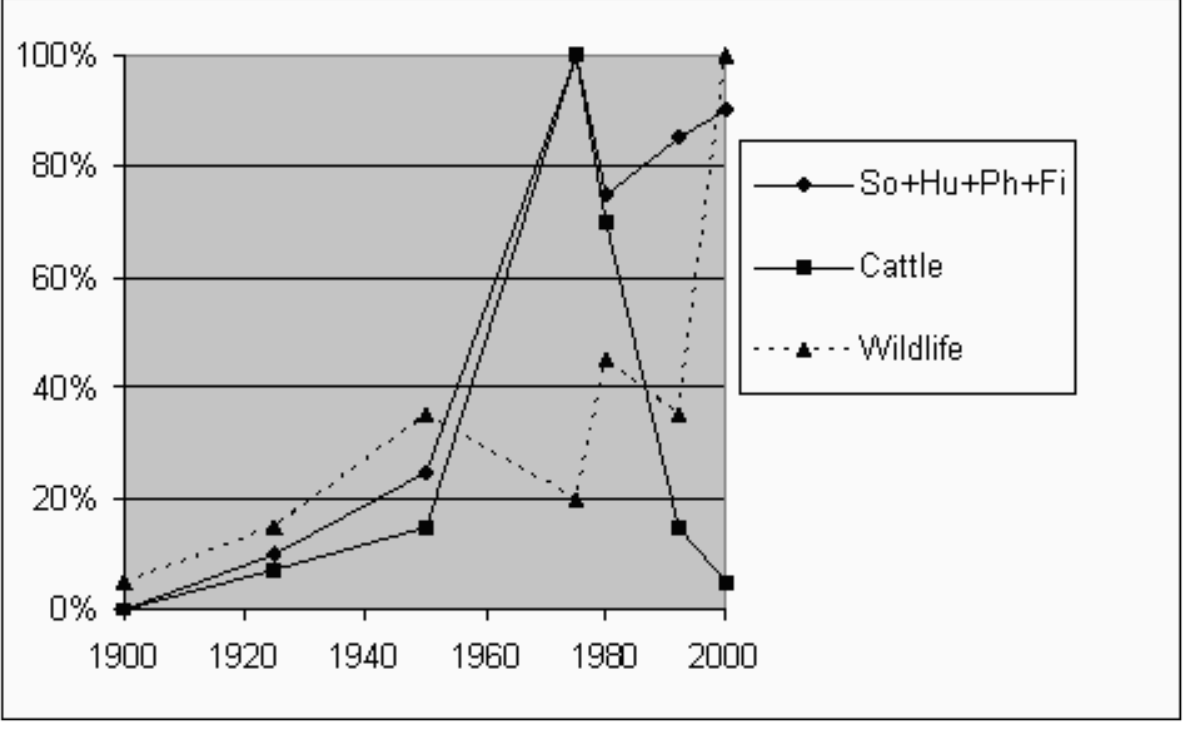
Fig. 2 . Postulated changes in levels of capital during the transition from cattle ranching to wildlife ranching and tourism is the South East Lowveld of Zimbabwe. The years before and after release ( W ) and reorganization ( &#0945 ) are shown. Social capital (So), human capital (Hu), physical capital (Ph), and financial capital (Fi) followed very similar trends and have been lumped together. The initial decline in cattle ranching occurred during the war of independence as a result of cattle rustling followed by a decline in the terms of trade and a major drought in 1991&#82111992. Levels of capital are represented relative to the maximum level reached during the period of history we analyze. Levels of capital can be compared within but not between categories of capital. The lines joining the time axes represent the trend between years correctly, but they do not track fluctuations. The level of natural capital refers only to that natural capital accessible to ranchers. These levels are based on our opinions and interpretations of